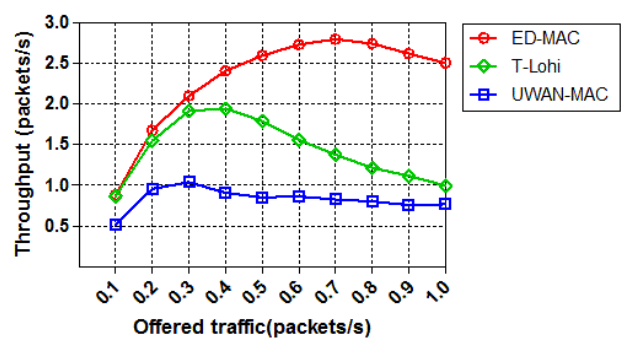
Figure 13. Throughput vs. offered traffic.